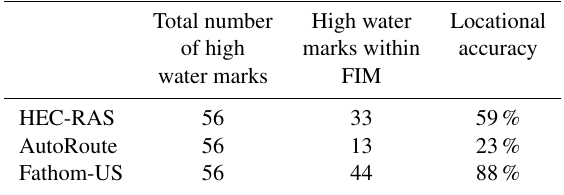
Table 1. Locational accuracy of each modeling-framework FIM based on the number of HWMs within the FIM flood